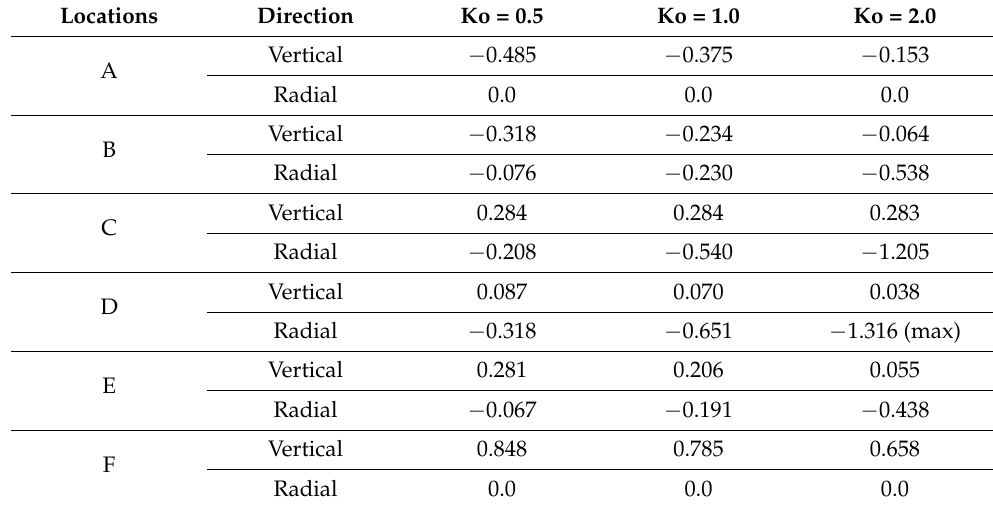
Table 4. Displacements at key locations obtained through 2D analysis (unit: mm).